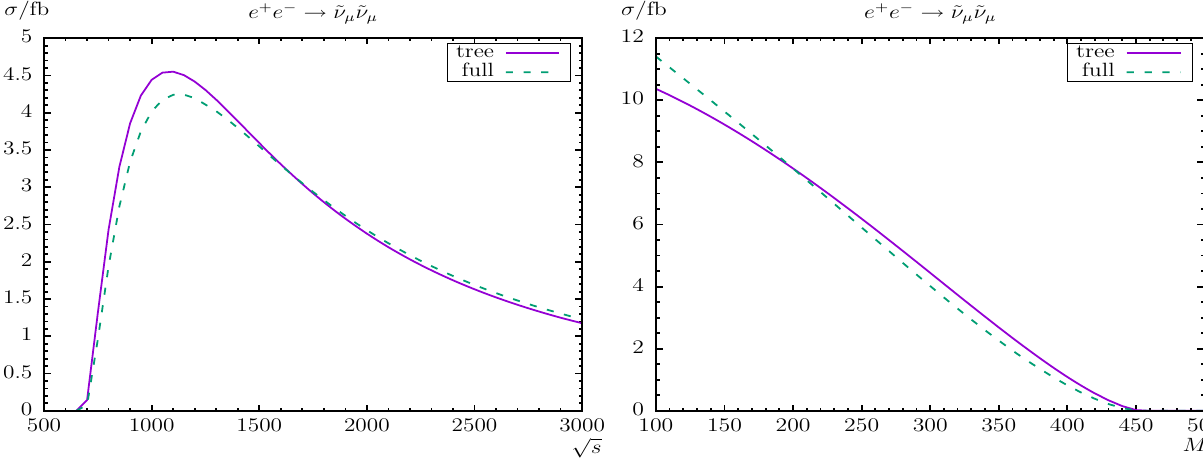
Fig. 19 σ( e + e − → ˜ ν μ ˜ ν ∗ μ ) . Tree-level and full one-loop corrected cross sections are shown with parameters chosen according to S ; see Table 1. √ s (left) and M ˜ (right) varied. All masses and energies are in The plots show the cross sections with E